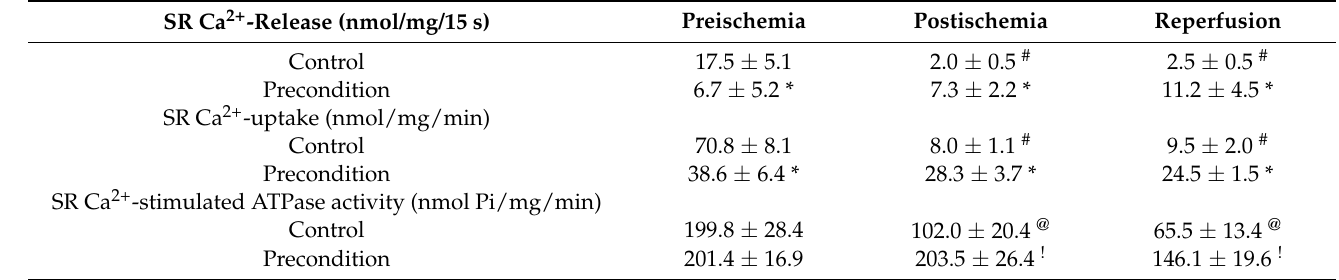
Table 2. SR Ca 2+ -release and -uptake activities and SR Ca 2+ -stimulated ATPase activity in preischemic, ischemic and ischemic–reperfused control and preconditioned